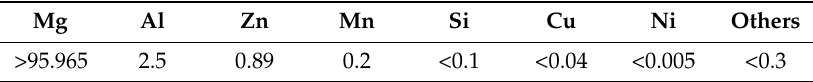
Table 1. Chemical composition of magnesium alloy AZ31B Mg alloy. (wt %).